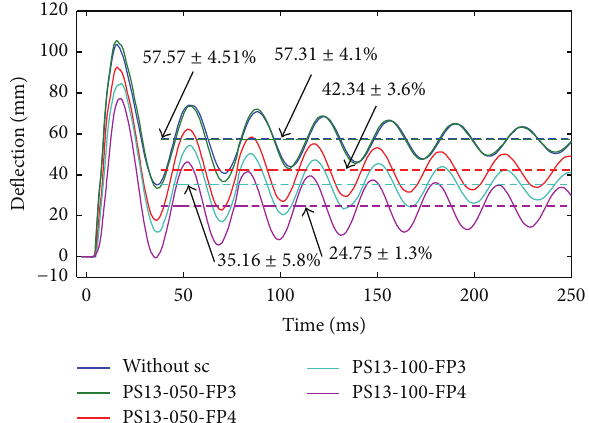
Figure 12: The midspan deflection of PS13-050-FP3, PS13-050-FP4, PS13-100-FP3, and